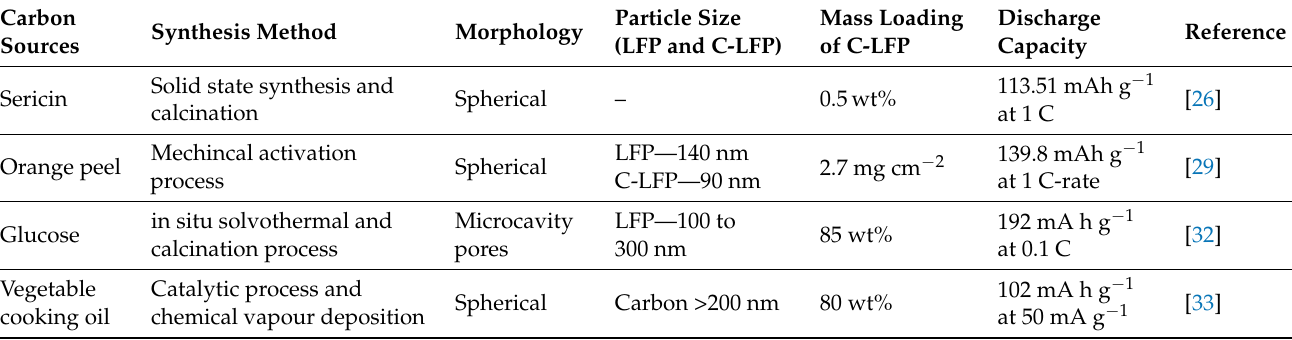
Table 1. List of recent works on biomass-derived carbon-coated